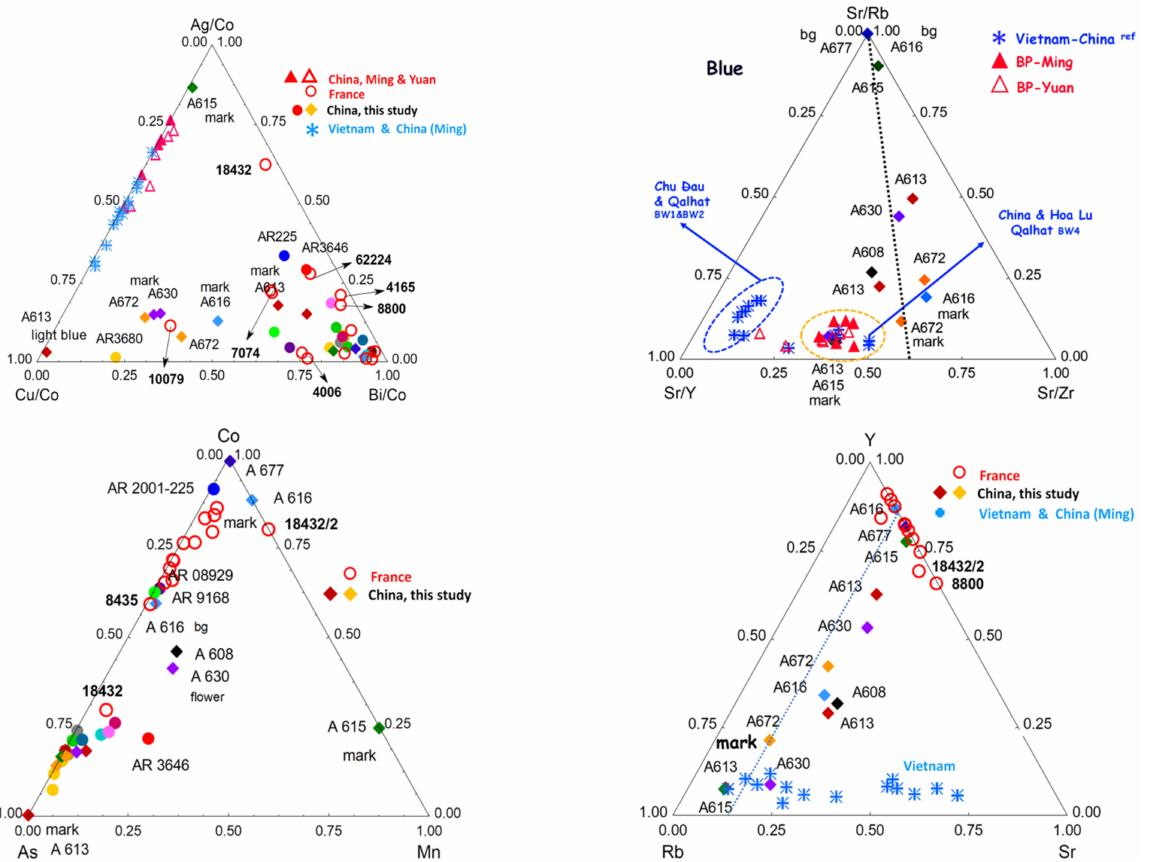
Figure 15. Comparison of the net number of photons of the major, minor, and trace elements measured on the blue-colored areas (rhomboids for Baur Foundation collection (A) and solid circles for Ariana collection (AR) published in [52]). Samples labeled with AR are porcelains from Jingdezhen kilns enameled at Guangzhou or Jingdezhen [52]. Reference data (open and solid red triangle referring to Yuan and Ming artifacts [96–98], open red circle to French soft-paste porcelain [66], and blue star referring to Vietnamese and Chinese artifacts [96,99]) are added for comparison. Objects with special characteristics are indicated (see Table 1). See references for artifact photos; inventory numbers are indicated for artifacts located at the cluster border. Circles and lozenges of various colors, this study, see Figure 12